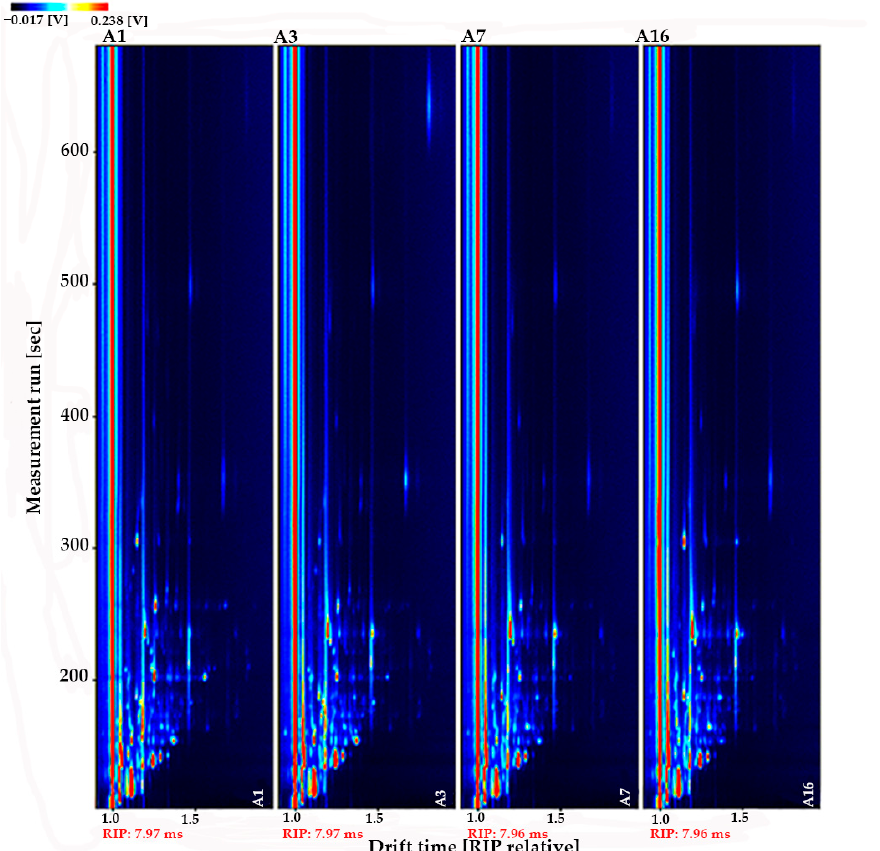
Figure 1. Two-dimensional spectra of volatile substances of different maturity rape honey samples (vertical view).